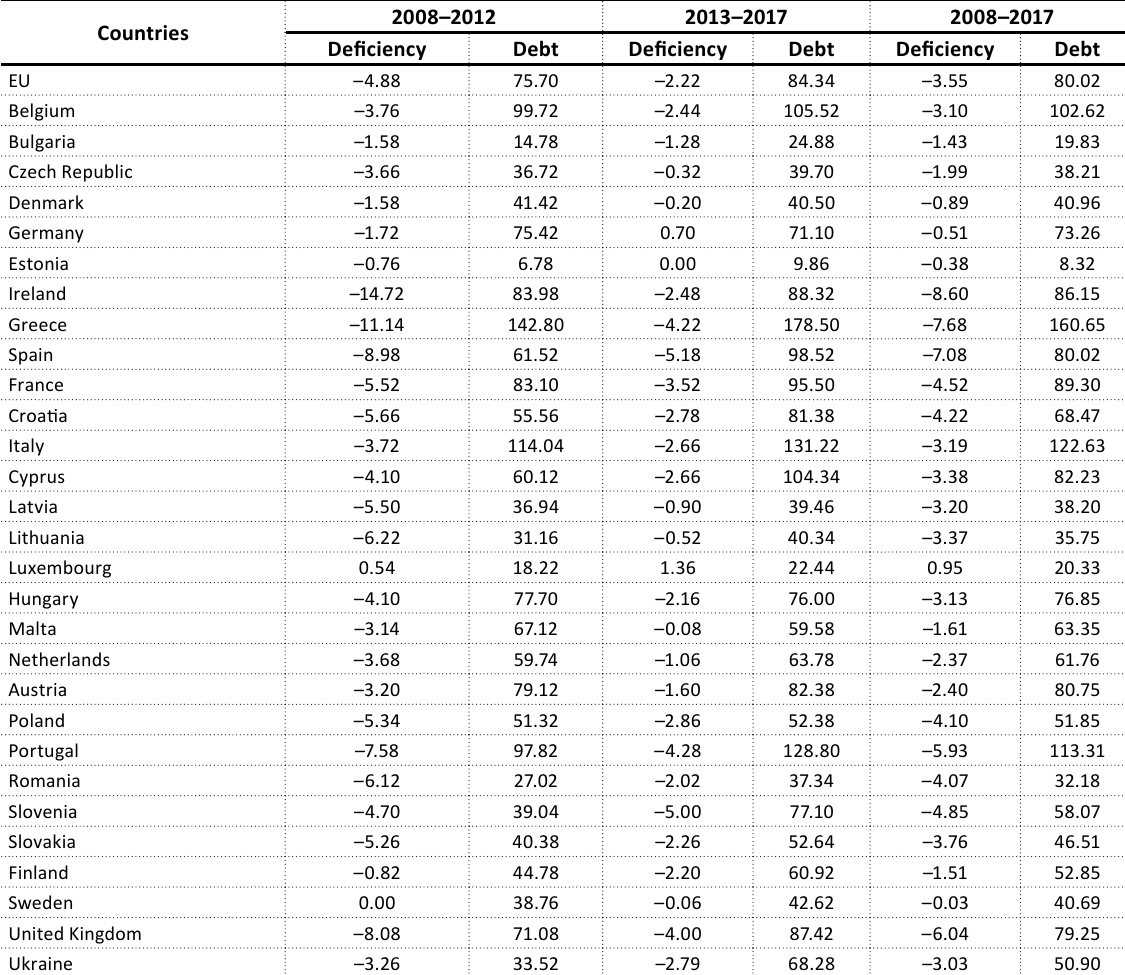
Table 2. The share of budget deficit and public debt in GDP for 2008–2017,